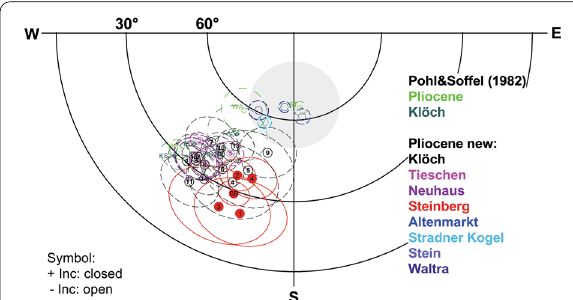
Fig. 9 Mean characteristic remanent magnetzations and α 95 of the Styrian volcanic rocks. The gray area shows the expected of secular variation. Data from Pohl and Soffel (1982) are shown for comparison